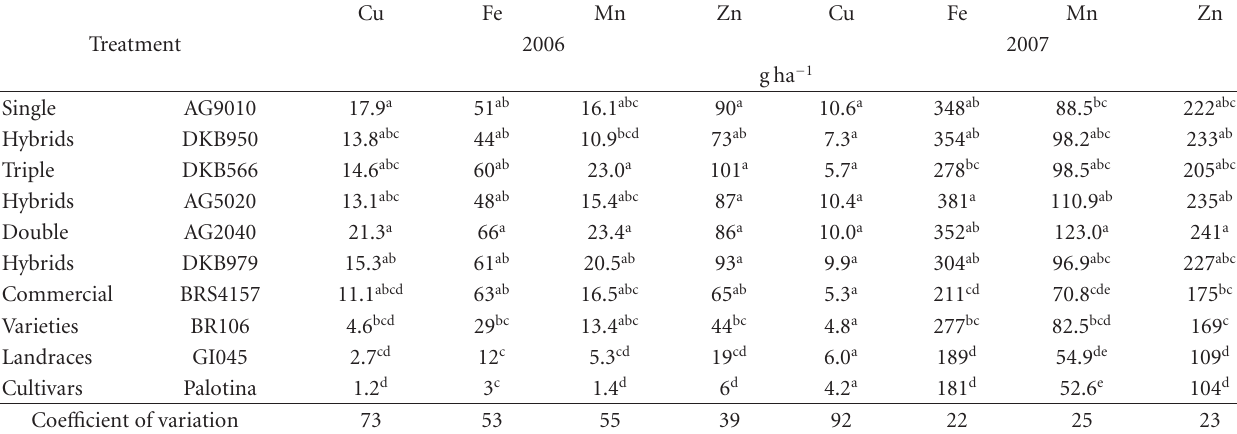
Table 5: Micronutrients exportation of maize cultivars 2006 and 2007, at Rolandia County, Parana State, Brazil. Cu Fe